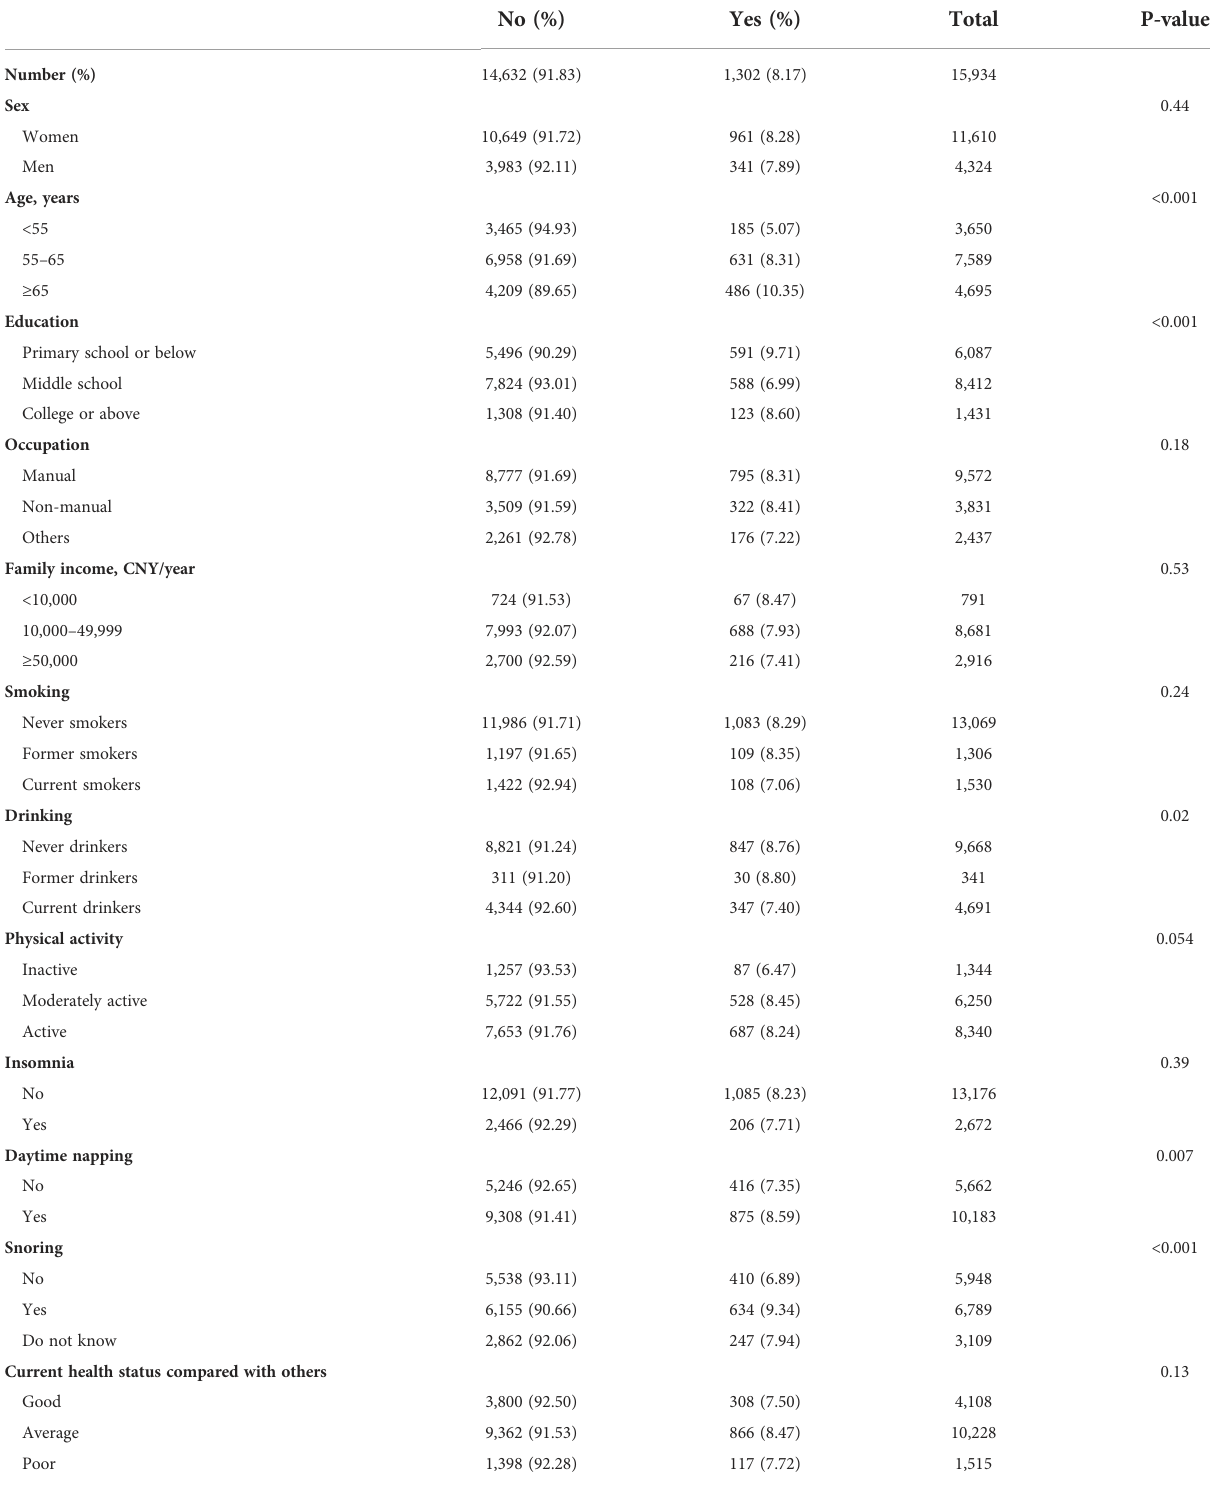
TABLE 1 Percentage of new-onset diabetes at follow-up during 2008 – 2012 by baseline demographic and clinical characteristics (25 variables) in all participants. Variables, N